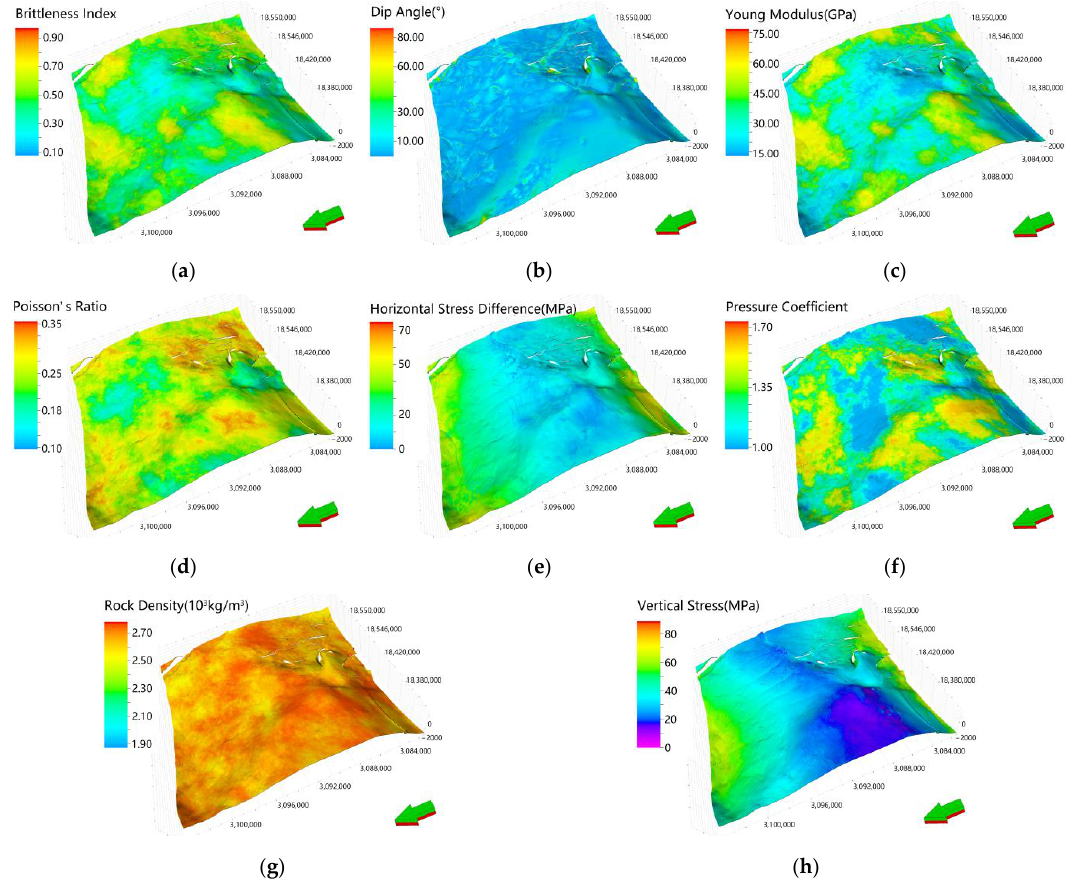
Figure 7. Three-dimensional evaluation index model of engineering sweet spots in the study area: ( a ) brittleness index; ( b ) formation dip angle; ( c ) Young modulus; ( d ) Poisson’s ratio; ( e ) horizontal stress difference; ( f ) pressure coefficient; ( g ) rock density; ( h ) vertical stress (models visualized by Schlumberger Petrel software).